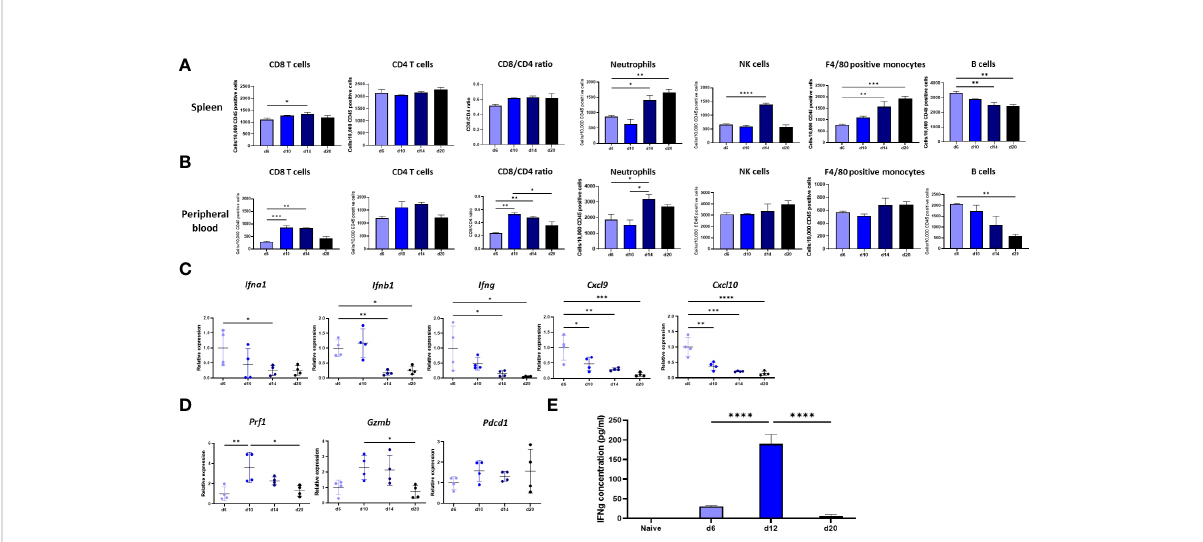
FIGURE 3 Immune response at remote immune sites. (A, B) . Changes in the immune content of the spleen and peripheral blood (PB) of tumor bearing mice between d6, d10, d14 and d20. The numbers, determined by fl ow cytometry, of CD8 and CD4 T cells, NK cells, neutrophils, F4/80 positive monocytes and B cells out of 10,000 CD45+ cells in the spleen (A) or peripheral blood (B) of tumor bearing mice are shown (n ≥ 6). The CD8/ CD4 ratio at both sites is shown as well (C) Tumor phase dependent expression in the spleen of genes that mark the anti-tumor response in the TME. The changes relative to d6 tumor mean expression of the IFNa , IFNb1 , IFNg , Cxcl9 and Cxcl10 genes in the spleen of tumor bearing mice between d6, d10, d14 and d20 are shown (n=4). (D) Tumor phase dependent expression of cytolytic and activation genes in the spleen.